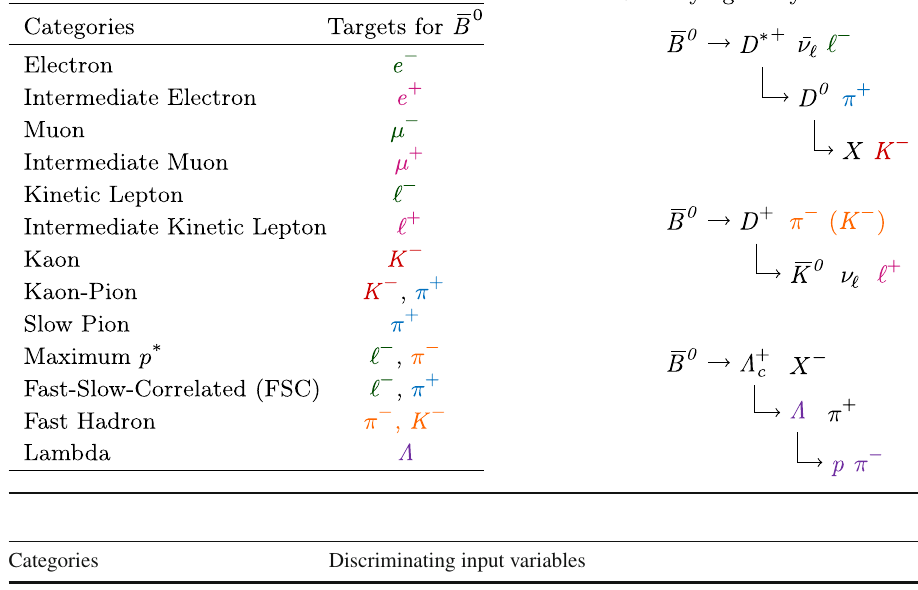
Table 2 Discriminating input variables for each category and for the DNN flavor tagger. For some of the categories the p -value of the track fit is taken into account. For the Lambda category, the p -value of the reconstructed (cid:11) -decay vertex is used. All variables are calculated for every particle